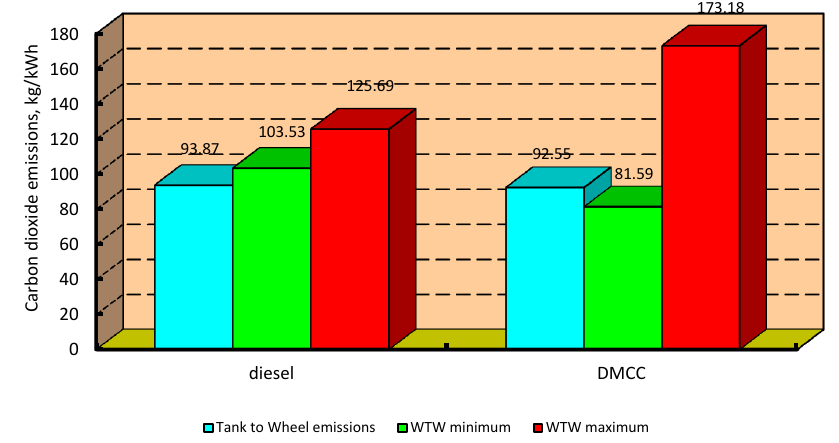
Figure 6. Carbon dioxide emissions per 100 km for diesel methanol compound combustion (DMCC) system.